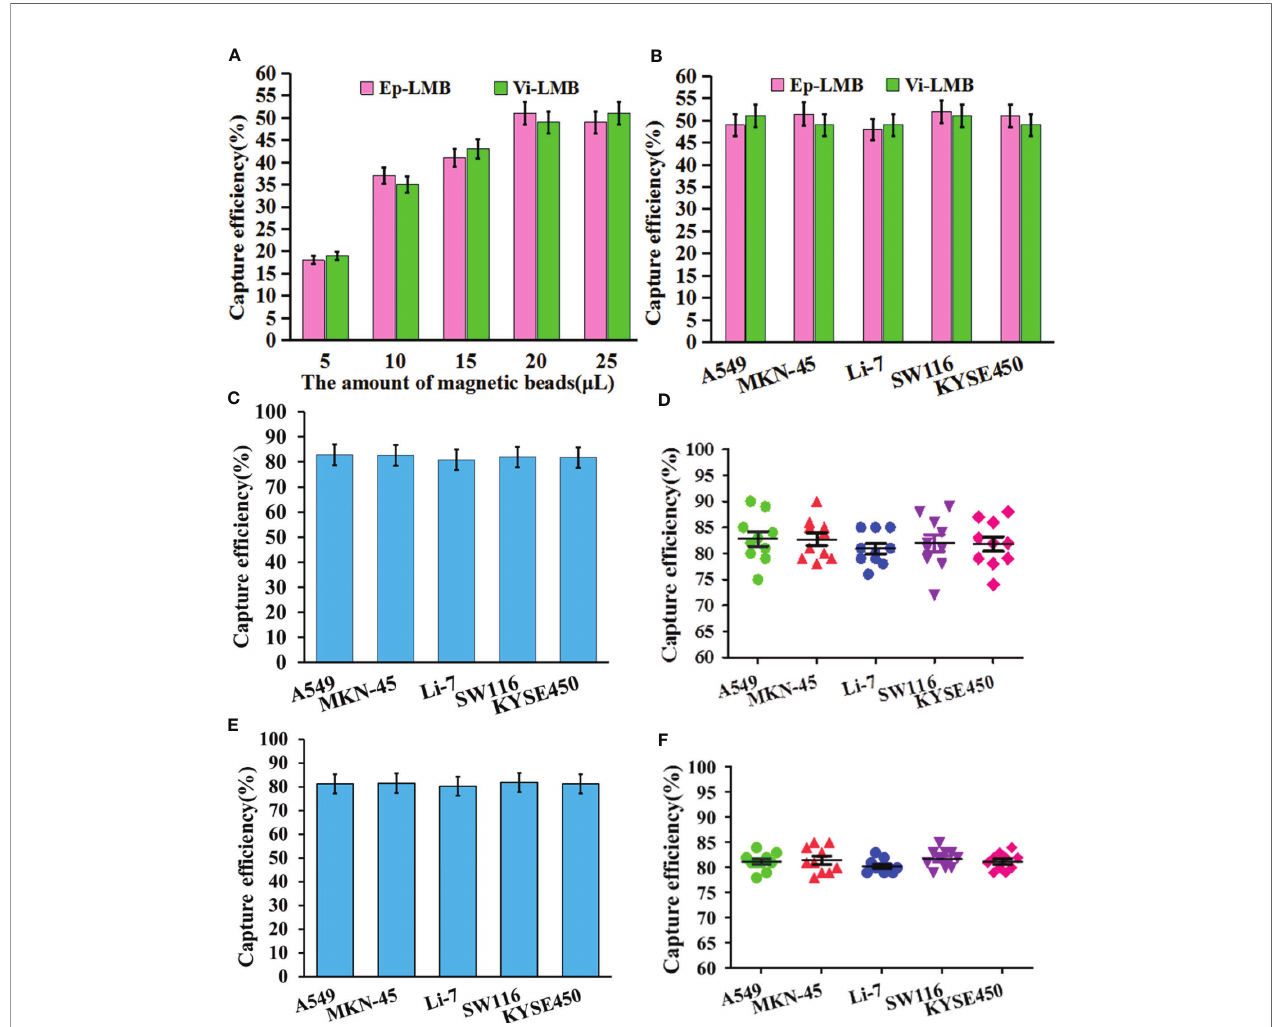
FIGURE 4 | In vitro simulation of CTCs capture ef fi ciency: (A) The capture ef fi ciency of Ep-LMB and Vi-LMB for A549 cells; (B) Capture ef fi ciency of Ep-LMB and Vi-LMB at 20mL for different cancer cell lines; (C) Total capture ef fi ciency of Ep-LMB combined with Vi-LMB for different cell lines in PBS; (D) Stability of the total capture rate for each cell line in PBS by the combination of Ep-LMB and Vi-LMB; (E) Total capture ef fi ciency of Ep-LMB combined with Vi-LMB for different cell lines in blood; (F) Stability of the total capture rate for each cell line in blood by the combination of Ep-LMB and